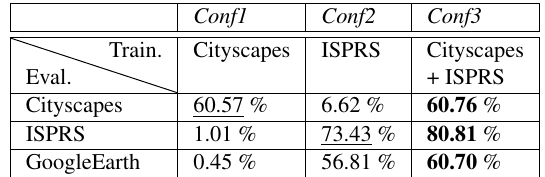
Figure 4. Precision-recall curves for different validation datasets. (a) Results achieved by the three training configurations evaluated on the Cityscapes validation set. (b) Results achieved on the ISPRS validation set. (c) Precision-recall values corresponding to an evaluation on the GoogleEarth dataset. Table 1. Quantitative results achieved by the three configurations evaluated on the three validation datasets. The underlined values represent the baselines as the training and evaluation was done on the same kind of